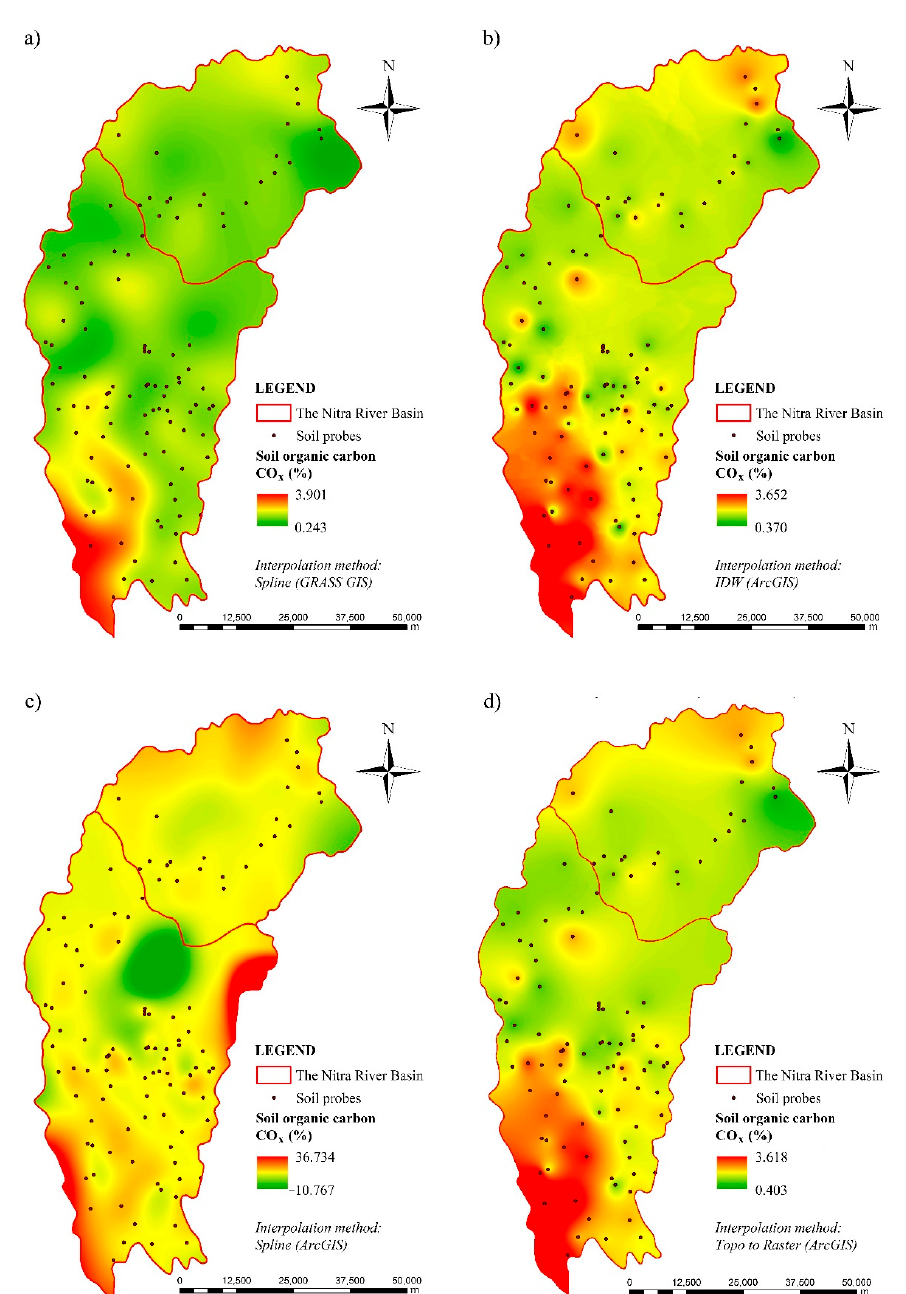
Figure 3. Spatial distribution of soil organic carbon content according to used interpolation methods: ( a ) Spline (GRASS GIS); ( b ) IDW (ArcGIS); ( c ) Spline (ArcGIS); ( d ) Topo to Raster (ArcGIS). Content of organic carbon (CO x ) was expressed in %. The input CO x from 112 sampling points ranged from 0.37 up to 3.65%. Once again, the interpolation method Topo to Raster resulted in dataset with the narrowest range of the values (0.37–3.65%) (Figure 3). Interestingly, it was similar as the set of input data; however, similar minimum and maximum values were observed also for the Topo to Raster method. The range of the dataset obtained by Spline in GRASS GIS was wider (0.24–3.90); however, the values were all above zero. After using Spline (ArcGIS), the interpolated values were again in a very wide range from − 10.77% up to 36.73%, including also negative values of CO x